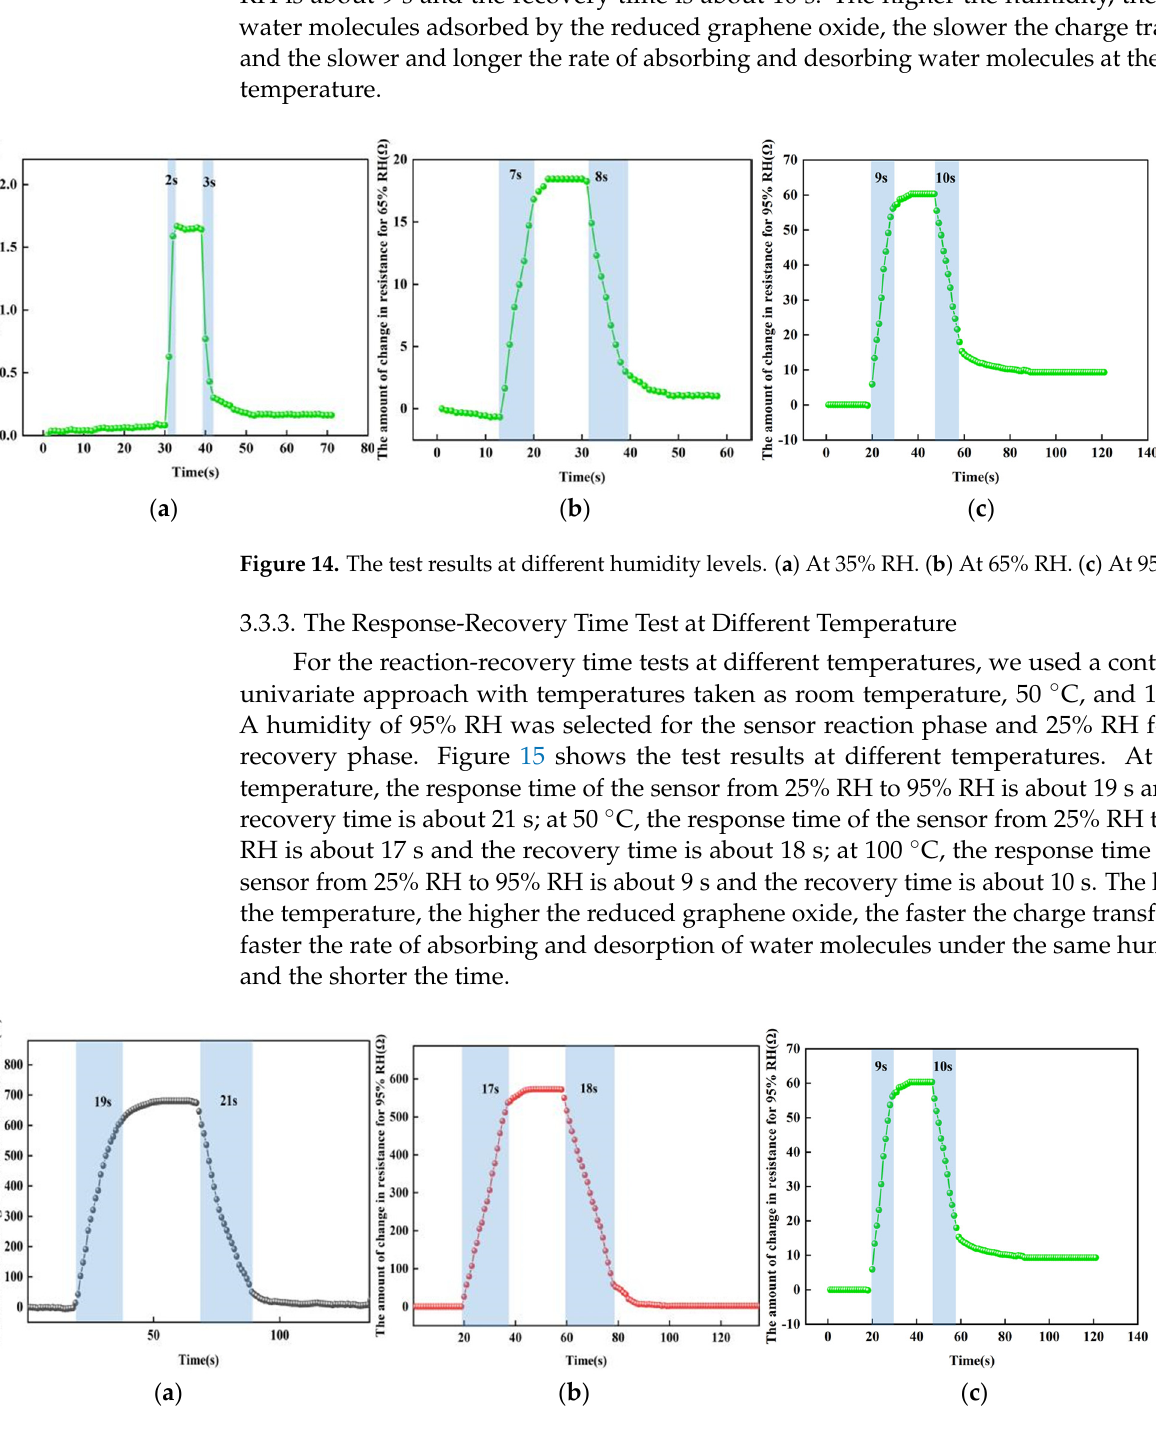
Figure 15. The response-recovery time tests at different temperatures. ( a ) At room temperature. ( b ) At 50 °C. ( c ) At 100 °C.